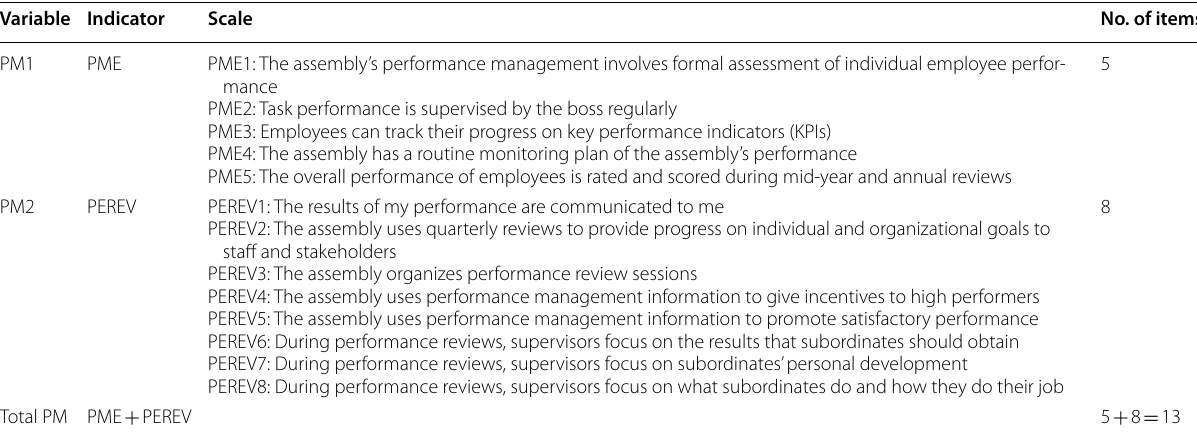
Table 12 Performance management construct Variable Indicator